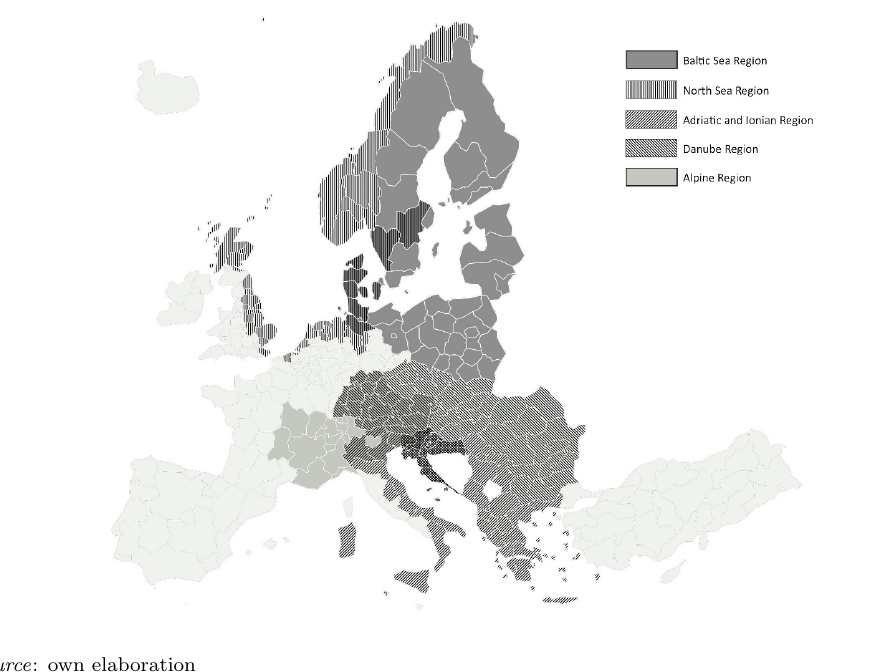
Figure 1: European